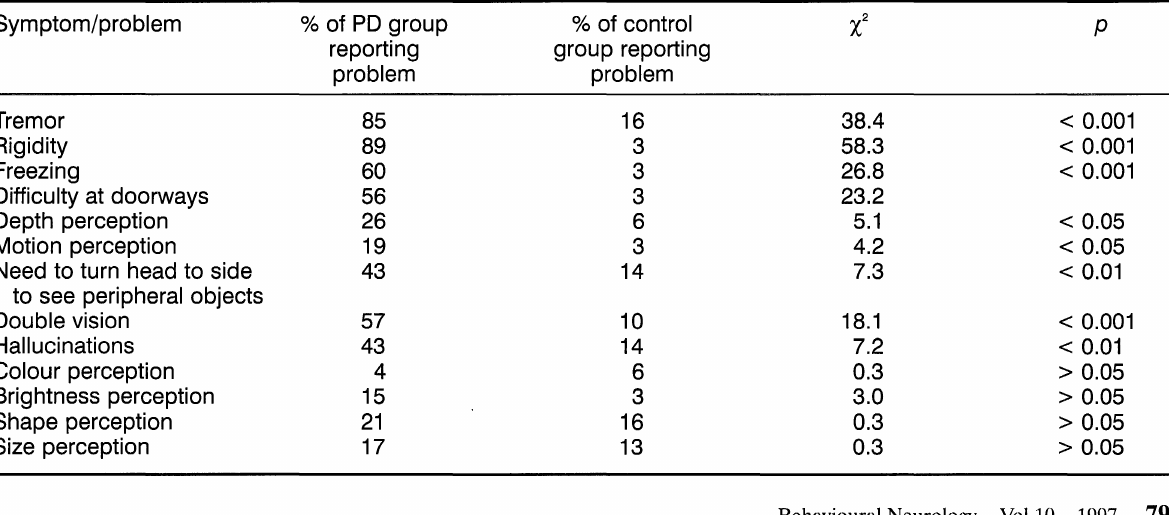
TABLE I: Percentage of subjects reporting the presence of problems in perception or the presence of a symptom Symptom/problem % of PD group % of